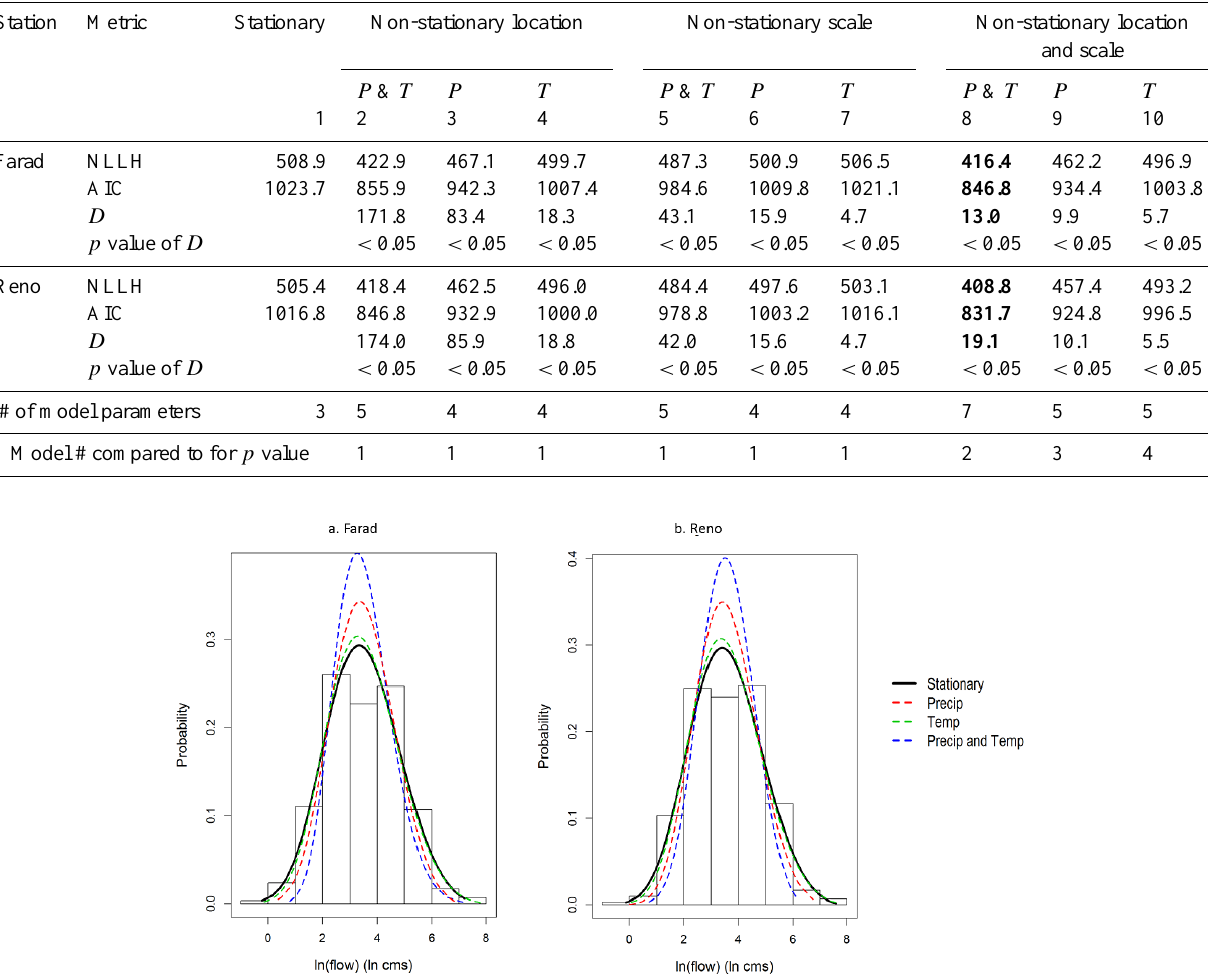
Table 2. Negative log likelihood (NLLH) and Akaike information criterion (AIC) scores for each model, as well as the deviance statistics ( D ) of pairwise comparisons of different model configurations ( P is precipitation only, T is temperature only and P & T are both) and the p values of each D score based on a chi-squared distribution. The number of parameters in each model and the models used for comparison are listed at the bottom of the table. The selected model for each station is in bold.